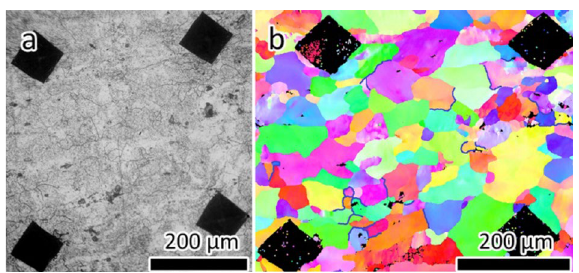
Figure 4. ( a ) Optical image showing the corroded microstructure after 2400 s exposure to H 3 PO 4 . ( b ) IPF map of imaged area with uncorroded grain boundaries highlighted by blue